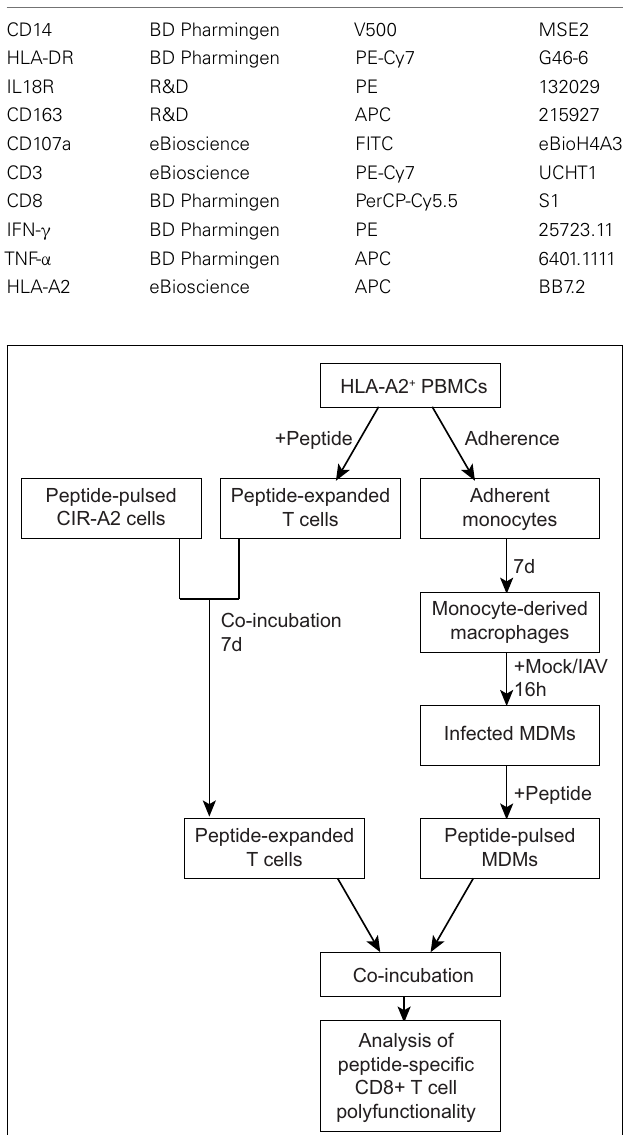
FIGURE 1 |An outline for the novel assay measuring interactions between human MDMs and CD8 + T cells . PBMCs were isolated from the buffy coats of healthy donors and were screened for HLA-A2 expression. Monocytes were isolated by plastic adherence, whereas peripheral blood lymphocytes were used forT cell assays. Monocytes were then differentiated into macrophages, infected influenza virus (or mock-infected), and pulsed with peptide. Peripheral blood lymphocytes amplified in vitro following incubation with peptide-pulsed C1R-A2 cells.